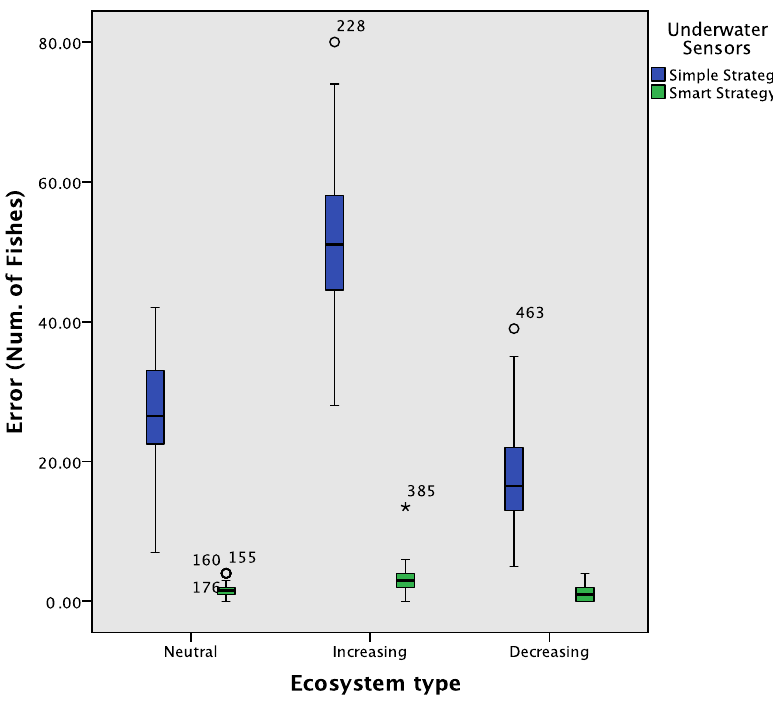
Figure 8. Comparison of errors with a boxplot considering the results of 100 simulations for each ecosystem and each underwater sensors strategy. Table 2. Robust tests of equality of means for comparing the errors between the two strategies. Statistic a df1 df2 Sig. Welch 977.017 1 305.170 0.000 ** Brown–Forsythe 977.017 1